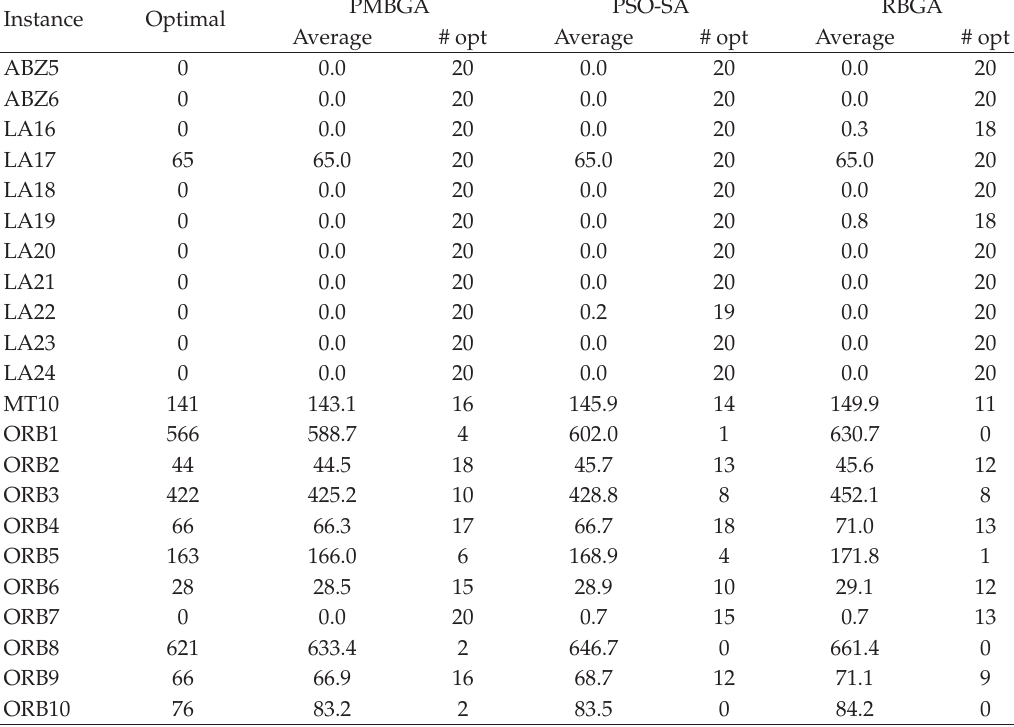
Table 1: The computational results and comparisons under f (cid:9) 1 .